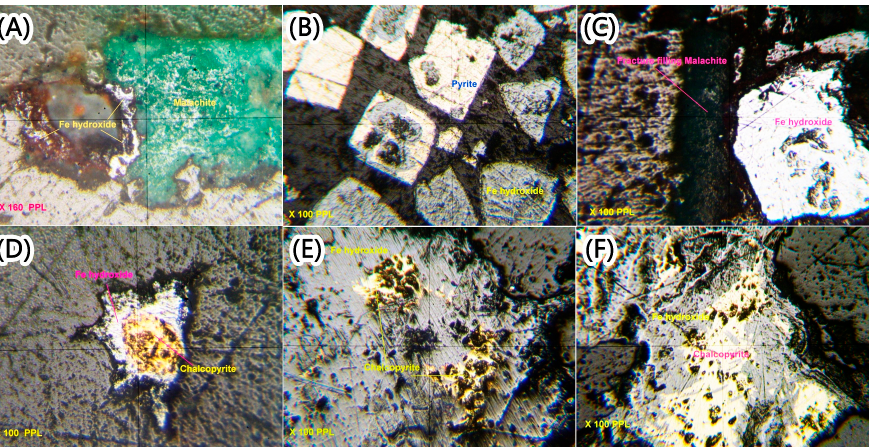
Figure 23. Polished sections of mineralogical samples from checked Points. ( A ) Malachite with Fe hydroxides in silica gangue; ( B ) Pyrite and Fe oxides, whose marginal parts have been replaced by limonite and goethite; ( C ) Fe hydroxides and malachite formed secondary along the fractures; ( D ) Chalcopyrite and Fe hydroxide in joints and fractures; ( E ) Chalcopyrite, most of which were replaced by Fe hydroxides due to supergene alteration; ( F ) Pyrite and chalcopyrite, limonite and goethite in the margins.